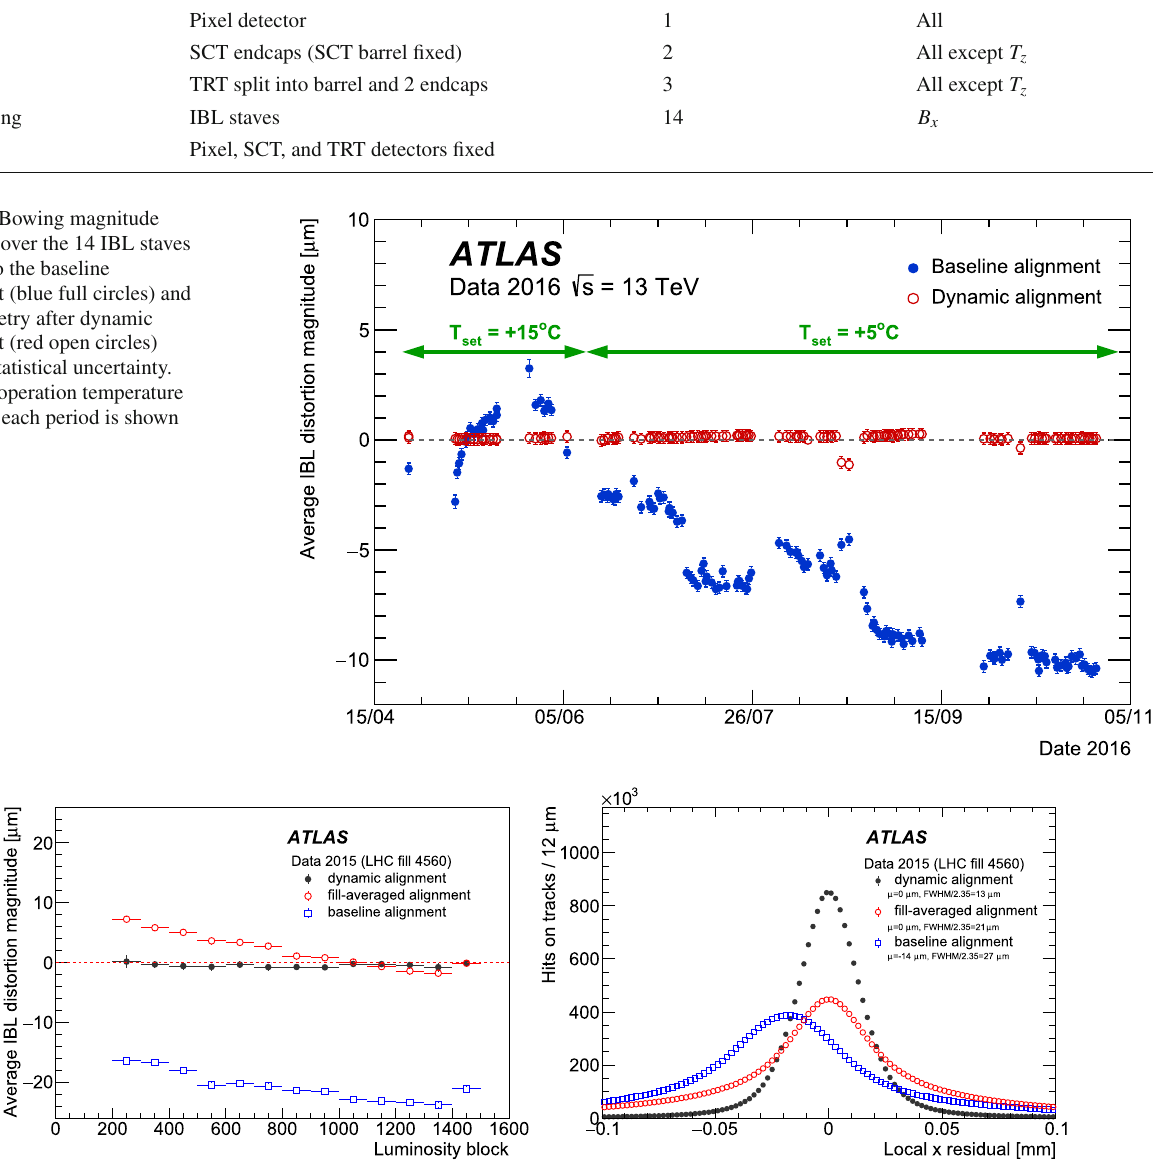
Fig. 11 IBL distortion magnitude in the transverse plane per lumi- nosity block (LB) range (left) and the IBL local- x unbiased residual distributions (right) for an LHC fill averaged over all 14 IBL staves. The open blue squares (baseline alignment) show the average IBL dis-